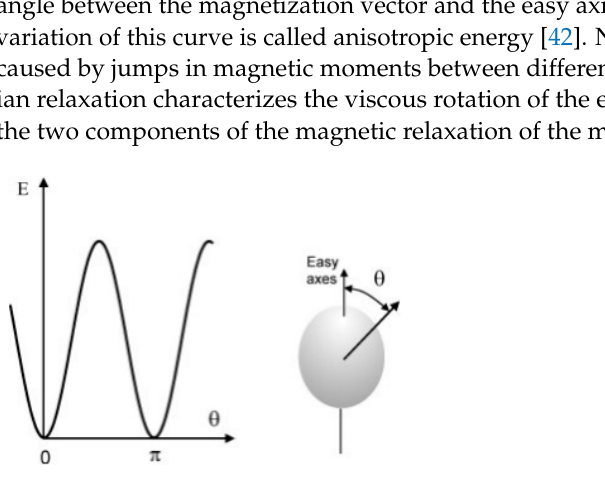
Figure 2. Trend of magnetic energy with tilt angle between easy axes [42].